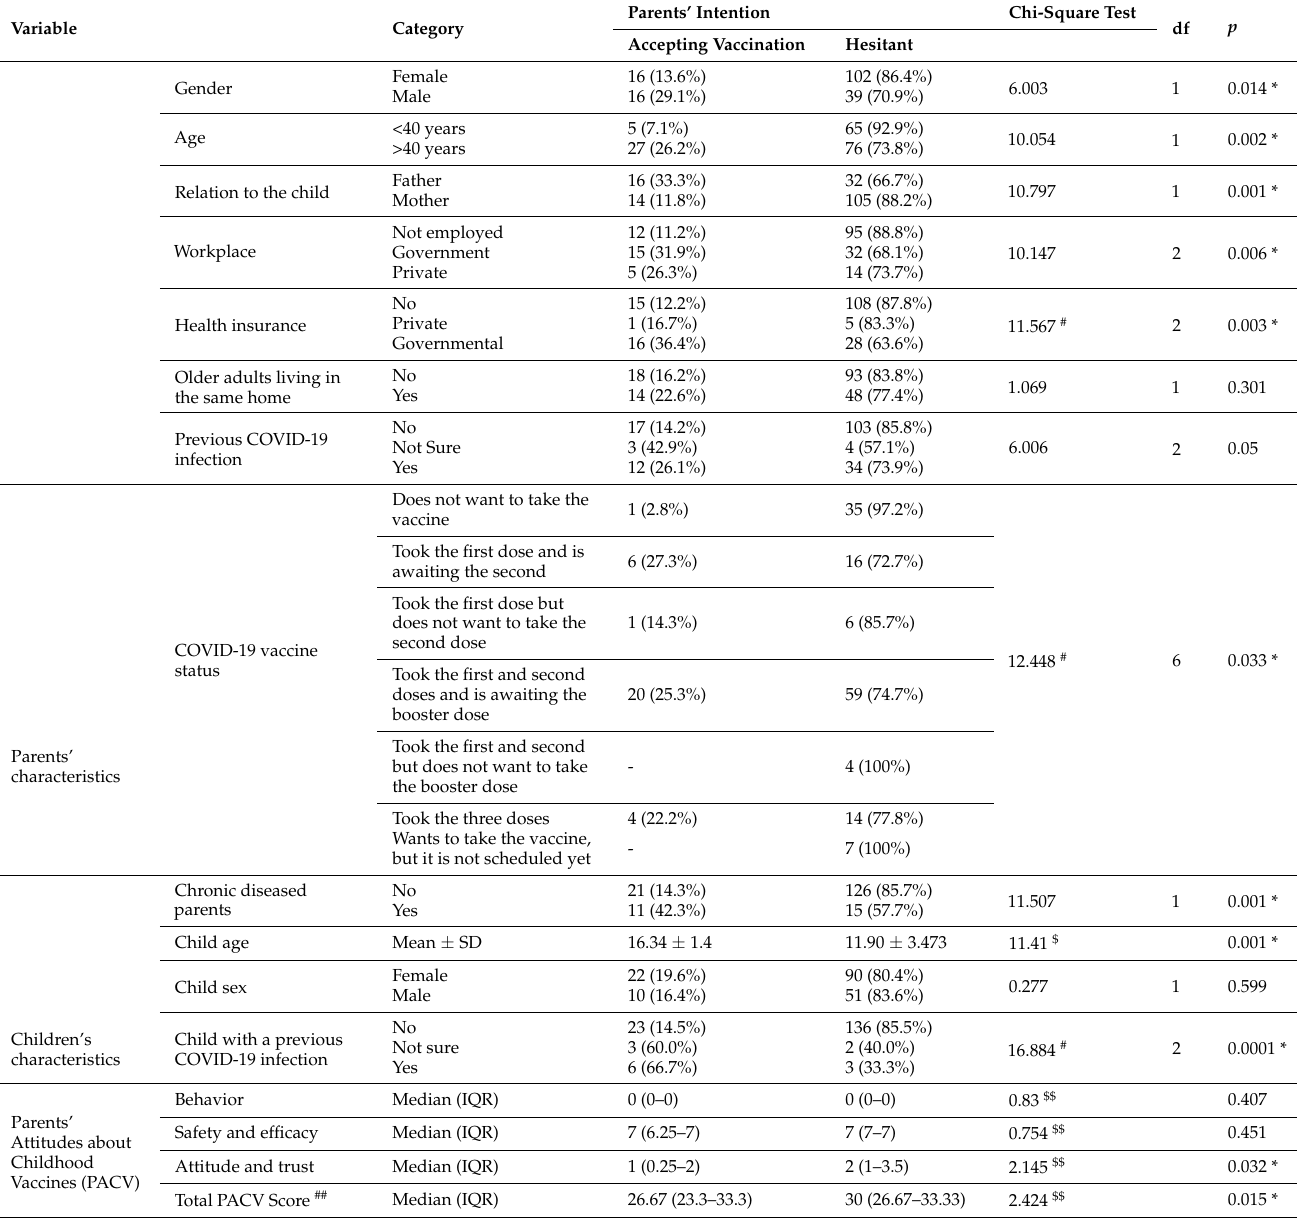
Table 3. Sociodemographic characteristics across vaccinated